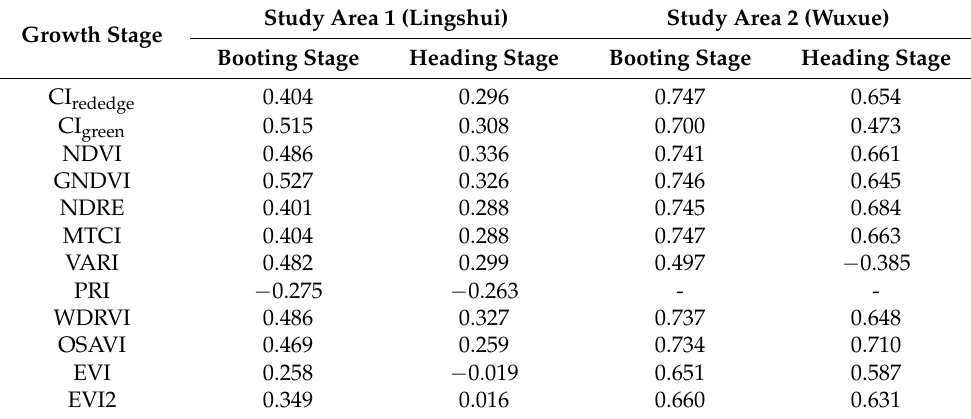
Table 2. The Pearson correlation coefficients of VI with yield at booting stage and heading stage. Growth